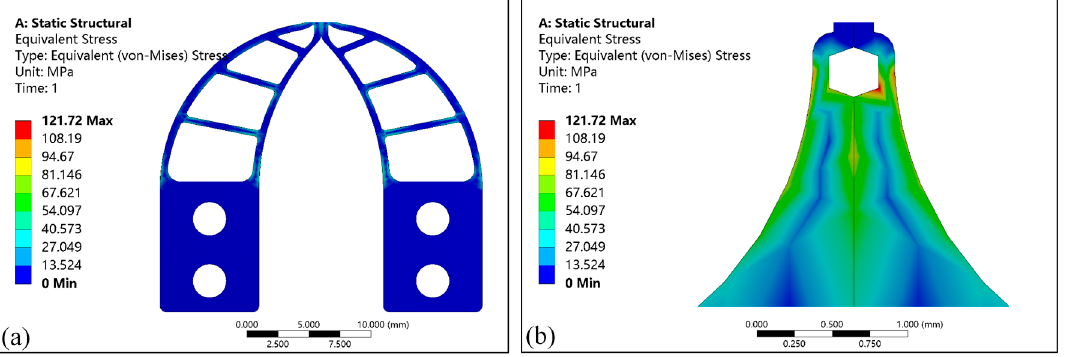
Figure 7. The simulation results of stress distribution for micro-gripper’s tip: ( a ) The stress distribution in the assembly and in elastic-beam regions; ( b ) The stress distribution in the tip-enveloped and tip-protected regions.